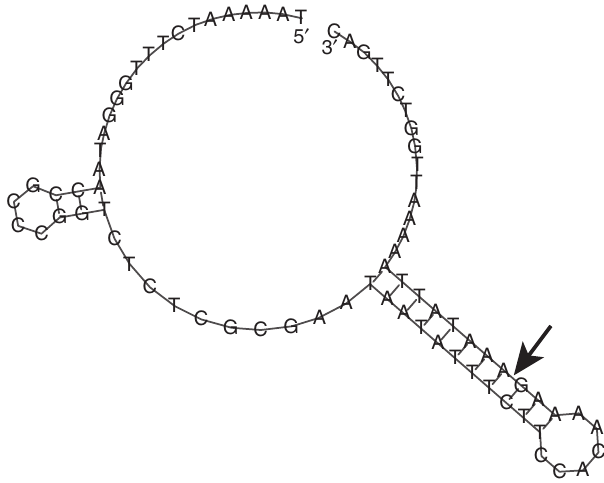
Figure 5 | 3 0 UTR hairpin sequence and structure as produced by RNAfold. The cleavage site of the NMV_1 mRNA is indicated by an arrow.